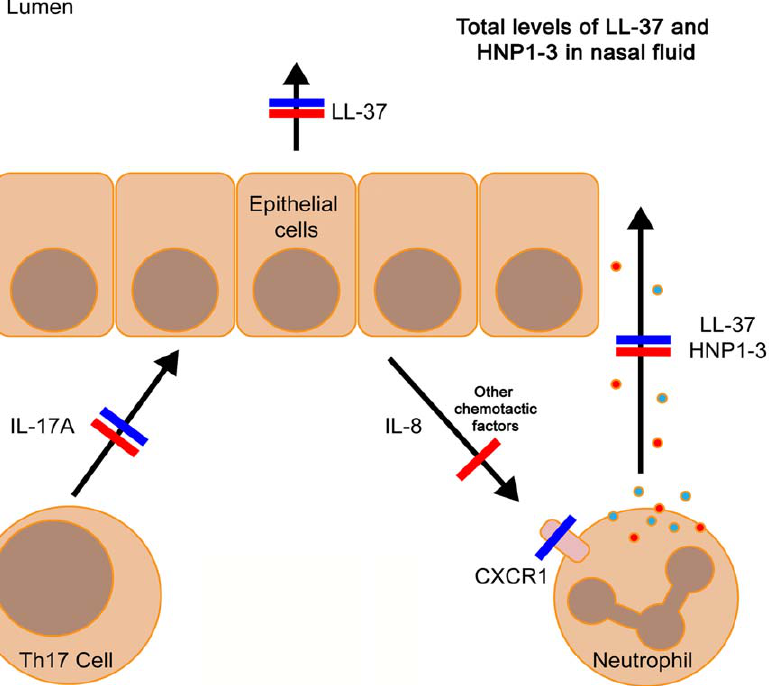
Figure 5. Impaired release of AMPs into nasal fluid of HIES- and CVID patients – A proposed model. HIES patients (blue lines) exhibit an impaired production of IL-17A and their nasal fluid contain very low levels of LL-37 and HNP1–3 despite normal chemotactic activity and IL-8 levels. This may be explained by defects in expression of the IL-8 receptor CXCR1, resulting in non-responding neutrophils. CVID patients (red lines) also exhibited a dysregulated release of AMPs, which may be explained by the low chemotactic activity of nasal fluid as well as an impaired Th17 response. However, CVID patients have, in contrast to HIES patients, normally responding neutrophils, but this may not be sufficient, since the chemotactic signal is too weak.